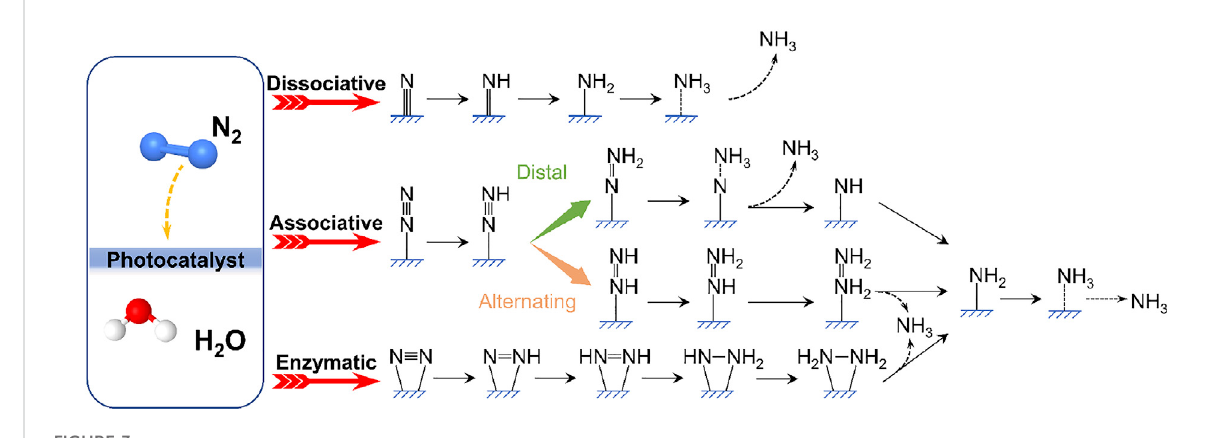
FIGURE 3 Schematic representation of possible pathways for N 2 fi xation to NH 3 on catalyst surfaces.